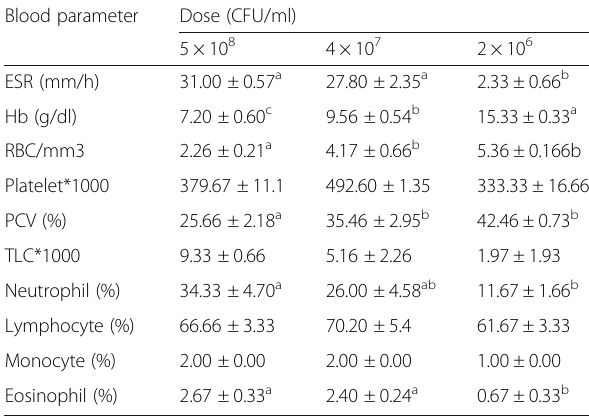
Table 2 Effect of different doses of S. aureus on hematological prameters of